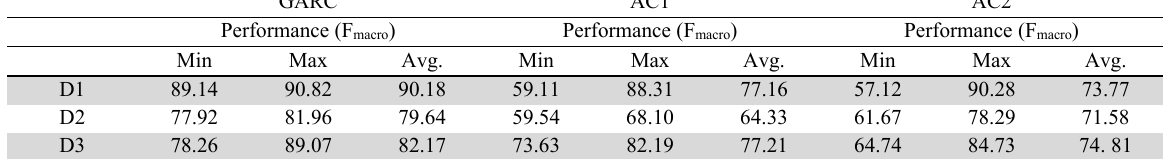
Comparison of GARC with ACs based on the categorization performance (macro average F-measure